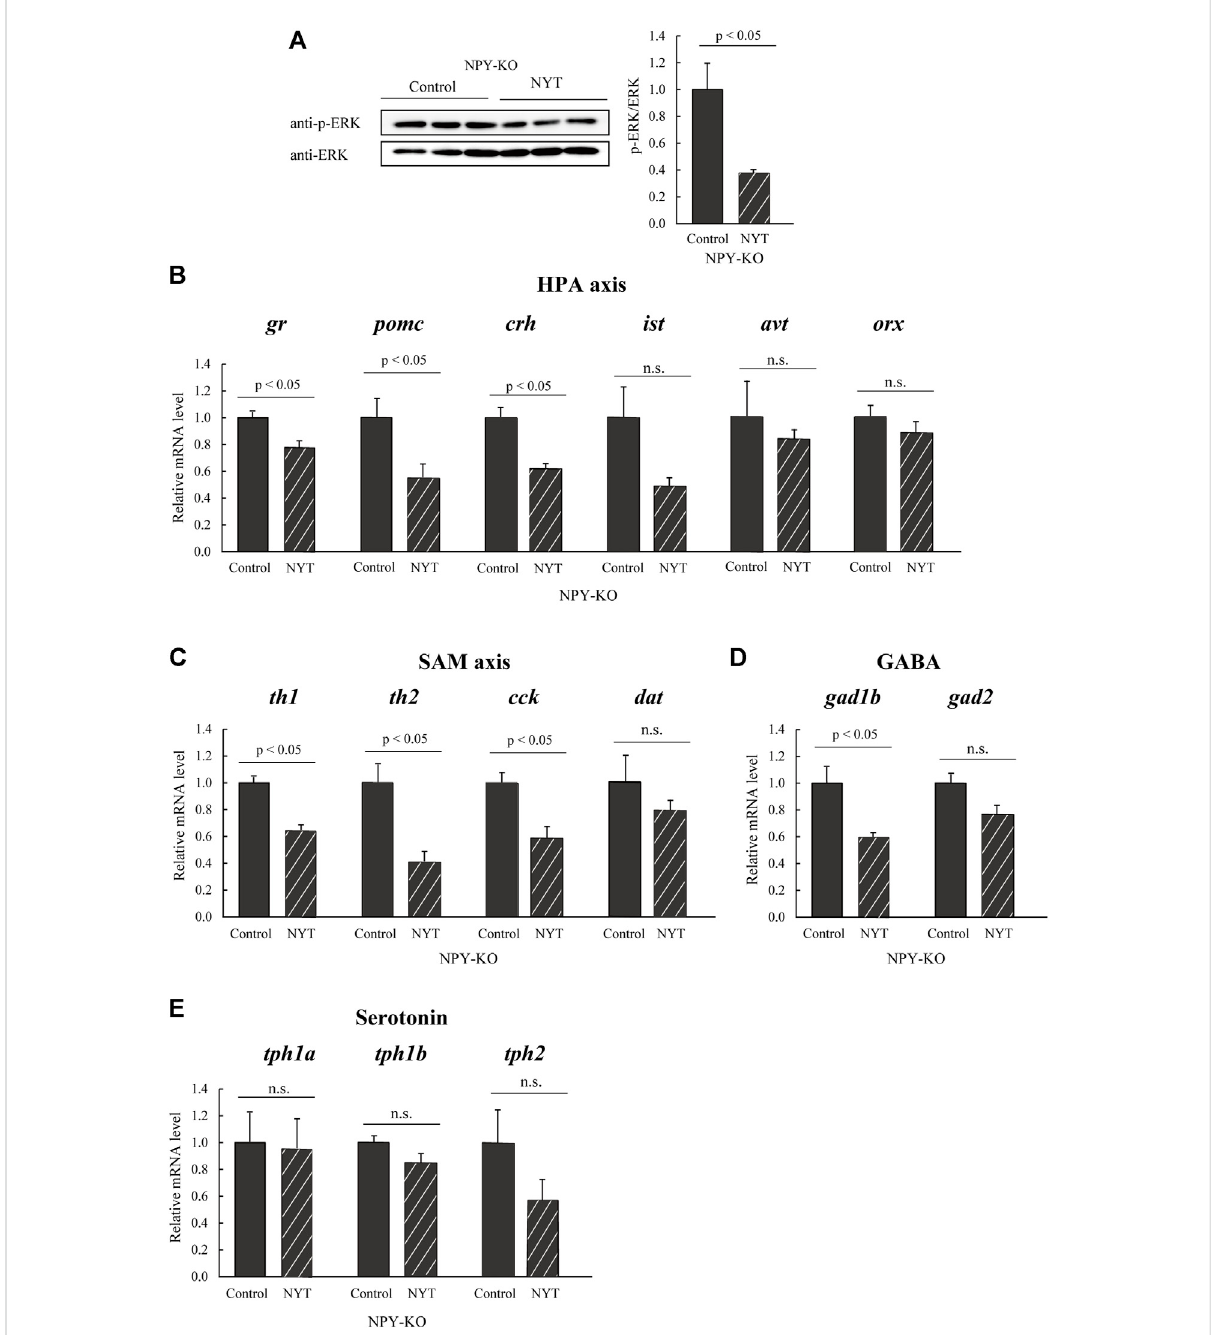
Effect of NYT on social behavior-related molecules in the NPY-KO zebra fi sh. The protein levels of (A) p-ERK were analyzed by immunoblotting with whole-brain lysate of the control — and NYT-fed NPY-KO zebra fi sh. The loading control used was (A) total ERK. n = 4. The mRNA levels of (B) HPA axis, (C) SAM axis, (D) GABA, and (E) serotonin-related genes were estimated by real-time PCR using whole brains of the control — and NYT-fed NPY-KO zebra fi sh. (B) HPA axis-related genes ( gr , pomc , crh , ist , avt , and orx ). (C) SAM axis-related genes ( th1 , th2 , cck , and dat ). (D) GABA- related genes ( gad1b and gad2 ). (E) Serotonin-related genes ( tph1a , tph1b , and tph2 ). The gene expression level of actb was used as an internal reference. Each gene expression level was relativeto that inthe control-fed NPY-KO zebra fi sh. n =5. Resultsare shown as mean± standard error of the mean. n.s., not signi fi